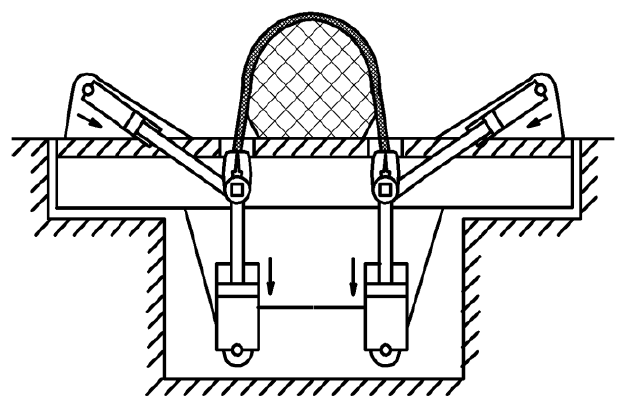
Figure 2. FET type pull